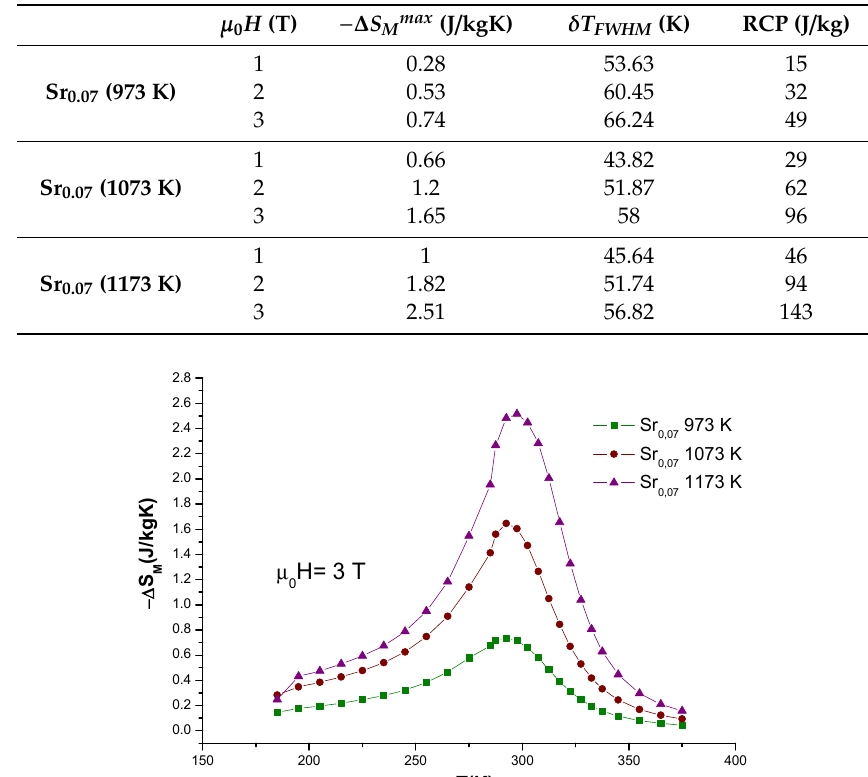
Table 2. Summary of magnetocaloric parameters for La 0.7 Ca 0.23 Sr 0.07 MnO 3 nanofibers under thermal treatment of 973, 1073 and 1173 K, respectively.